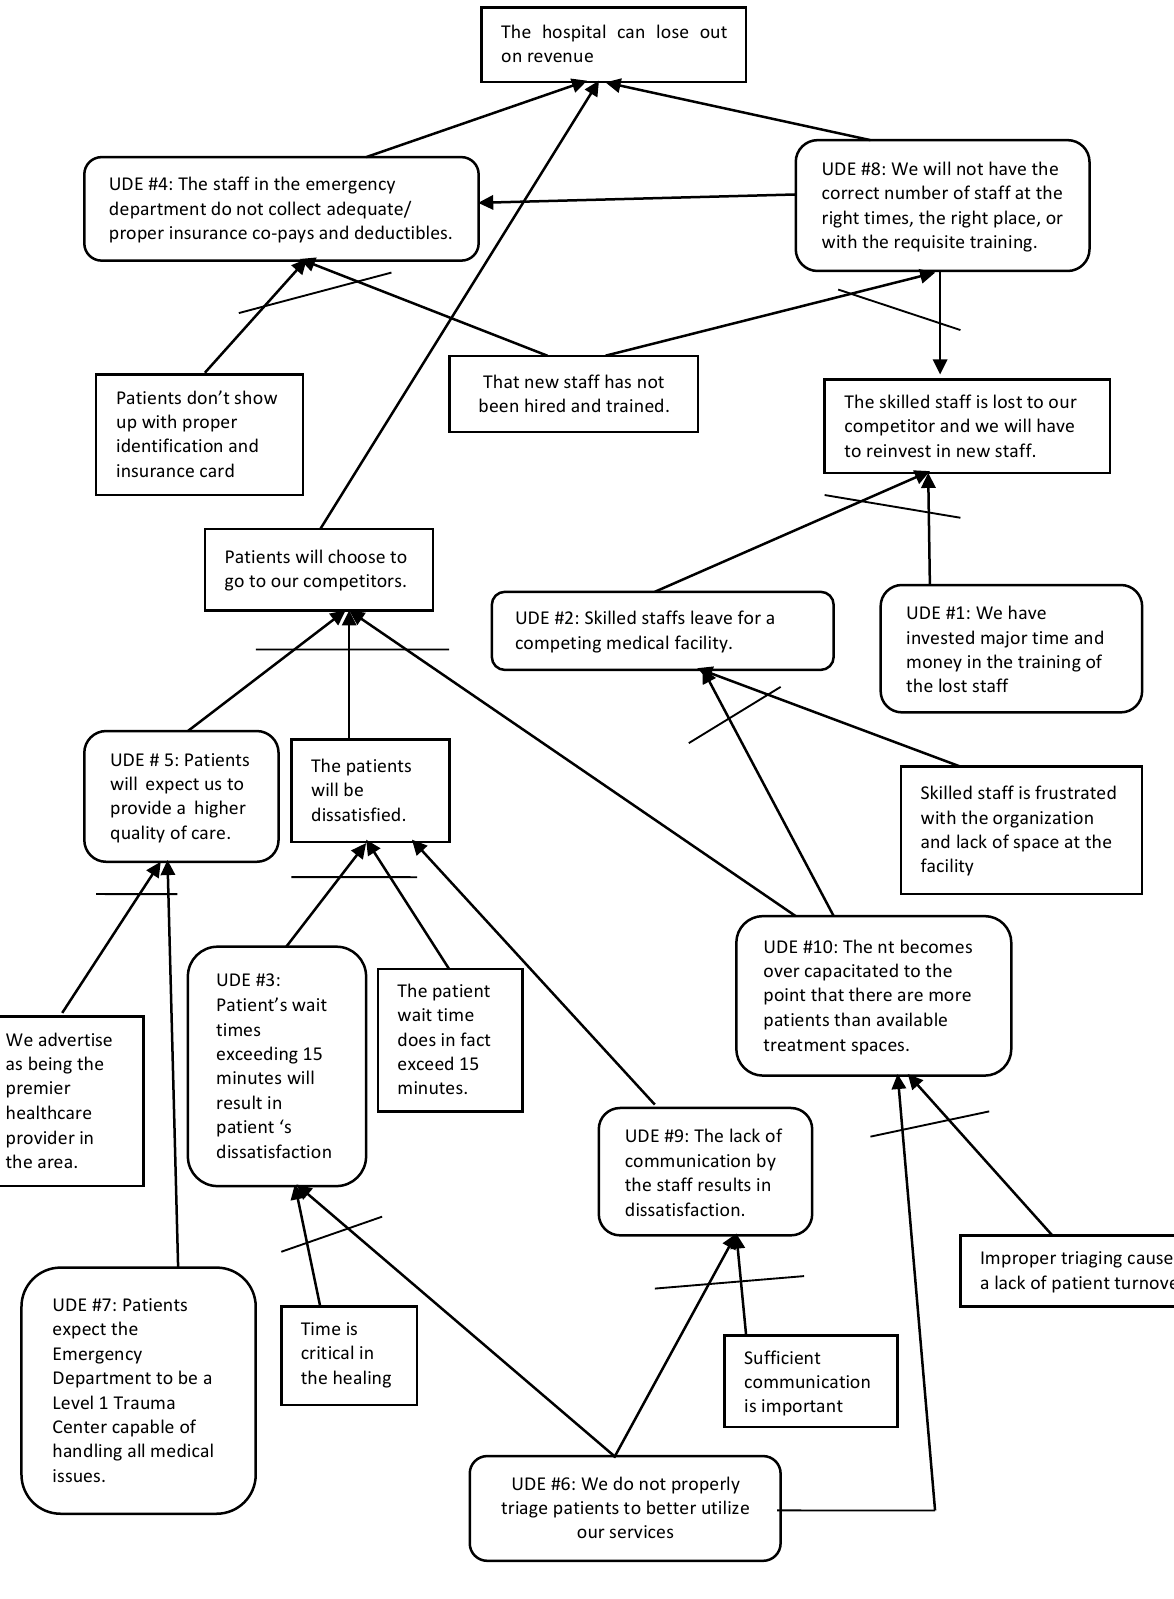
Figure 1. Current Reality Tree of Goldratt’s Theory Applied to the Problems Associated with an Emergency Department at a